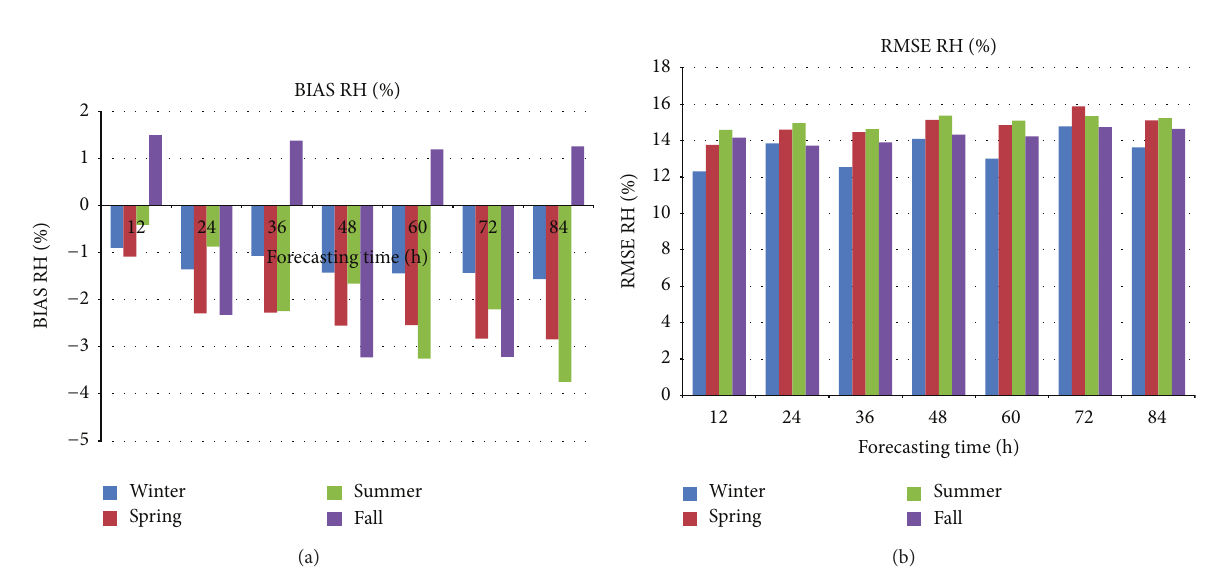
Figure 4: BIAS (a) and RMSE (b) for relative humidity for the four